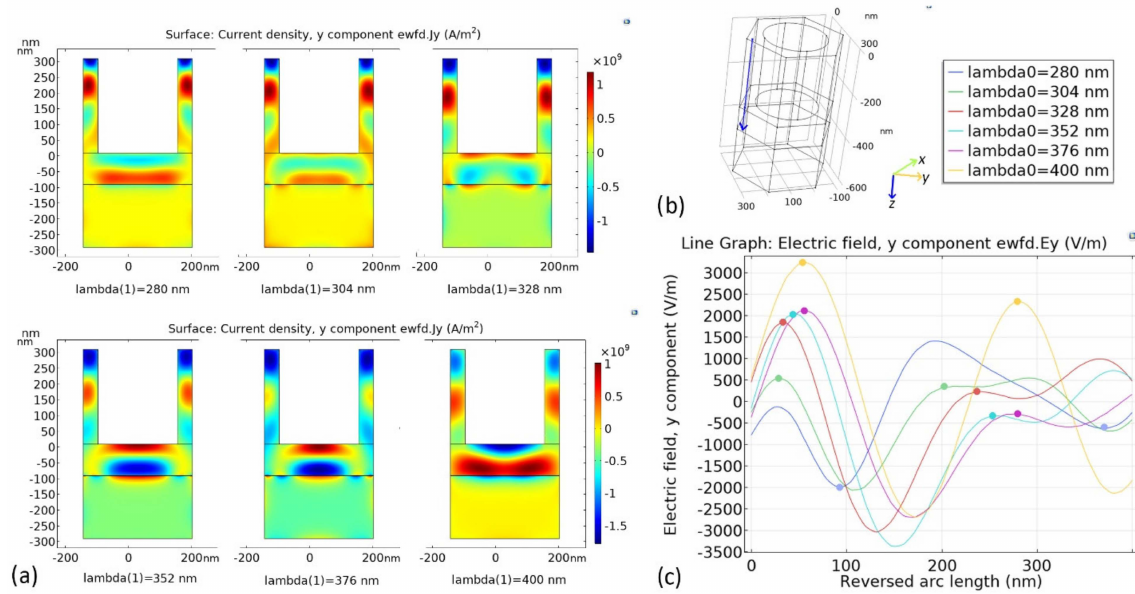
Figure 6. ( a ) Surface current density at the half-cut plane of single honeycomb hexagon at different wavelengths. ( b ) Blue line presents reverse arc length (path of decaying electric field). ( c ) Line plot of decaying electric field (V/m) as a function of reverse arc length presenting absorptance of UV irradiance in honeycomb GaN